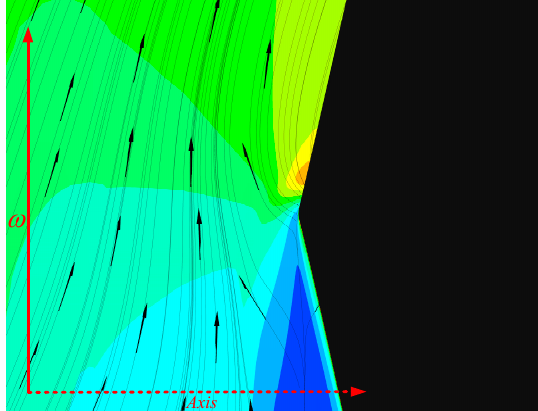
Figure 17. The absolute velocity vector distribution near the impeller inlet hub wall.